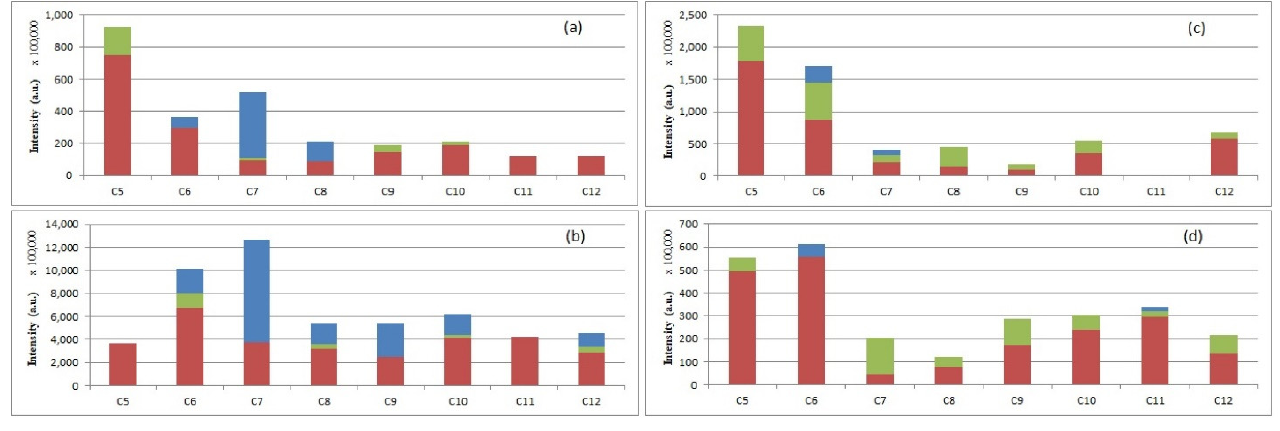
Figure 4. Chemical distribution of the main hydrocarbon families between C5–C12 after pyrolysis at 600 °C: ( a ) dry biomass without catalyst, ( b ) dry biomass with alumina catalyst, ( c ) n-hexane extract without catalyst and ( d ) n-hexane extract with alumina catalyst.